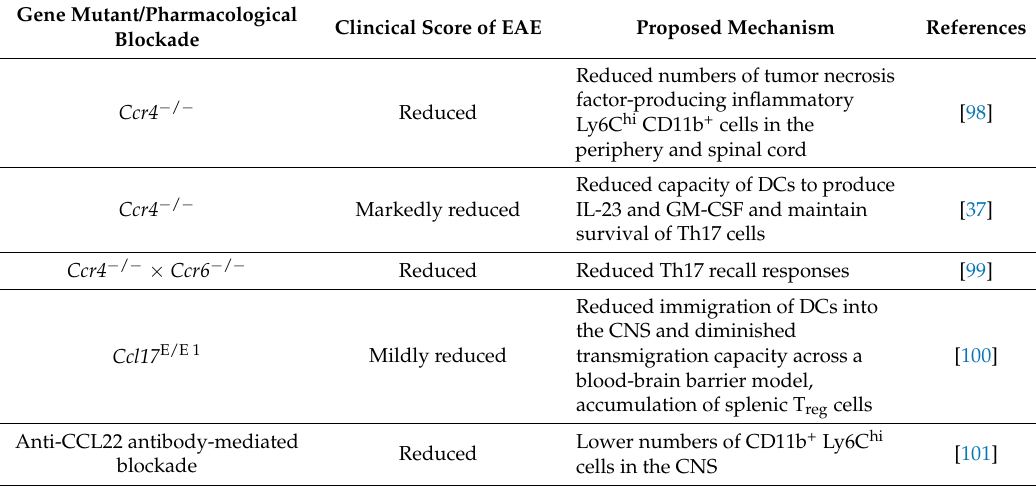
Table 2. Genetic and functional ablation of CCL17/CCL22 and CCR4 in EAE. Gene Mutant/Pharmacological Clincical Score of Blockade